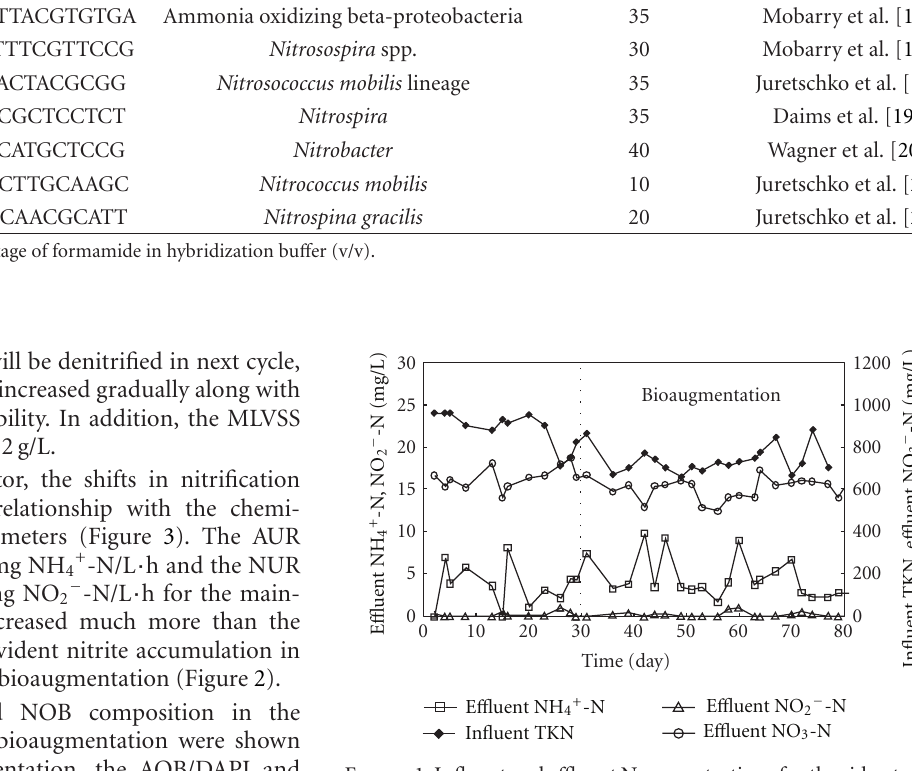
Figure 1: Influent and e ffl uent N concentrations for the side-stream reactor. Table 2: AOB and NOB composition in seed source (“—” no signals were